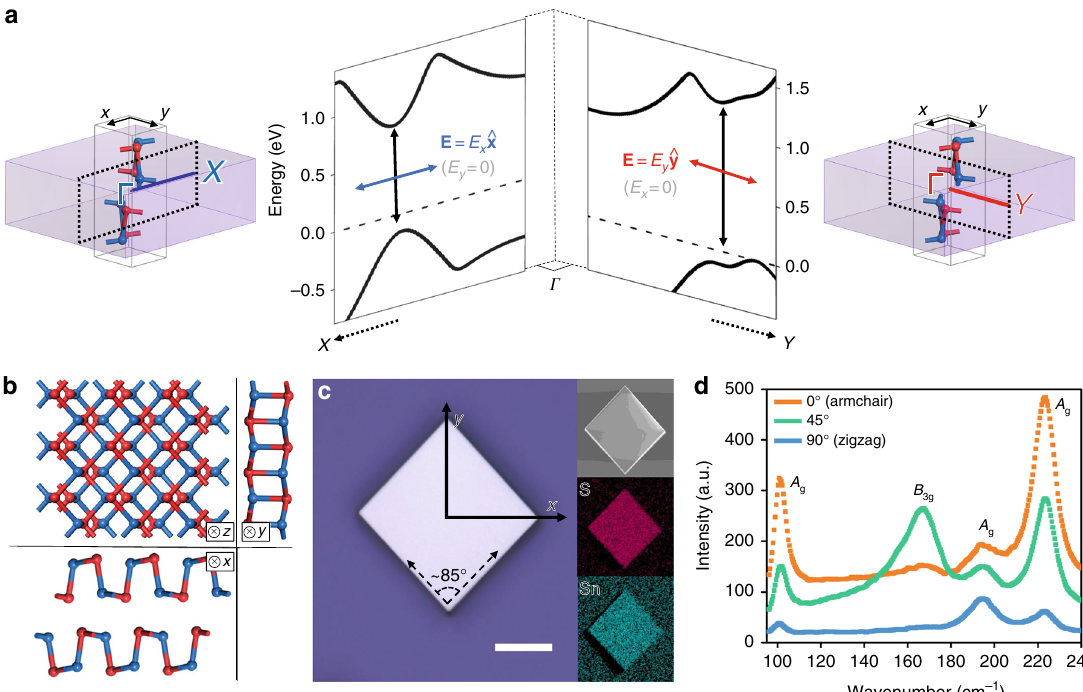
Fig. 1 Structure and characterization of SnS. a (Left and right) Three-dimensional (3D) representation of the Brillouin zone of SnS superimposed on a Pmcn unit cell made up of puckered layers, showing the collinearity of the x ( y ) axis in real space and the Γ X ( Γ Y ) axis in reciprocal space. (Middle) Quantitative view of the SnS band structure along X – Γ – Y , demonstrating the valley properties due to selectivity in linearly polarized light at non-degenerate band gaps. b Molecular structure of SnS visualized along the three main orthogonal axes projected from the unit cells presented in a , showing the correlation between the puckered arrangement of atoms and the high anisotropy along the y (armchair) and x (zigzag) directions. c Optical microscopy image of a SnS sample, showing a clear difference in angles made by the edges and ease of identifying the in-plane directions. Scale bar is 10 μ m. Inset shows scanning electron microscopy (SEM) images and energy-dispersive X-ray spectroscopy (EDX) maps, demonstrating a fl at surface and homogeneous distribution of Sn and S in equal ratio. d An example of Raman spectra obtained under parallel polarization, showing clear trends in intensities for the A g and B 3g modes, thus ascertaining the identity and orientation of the measured SnS